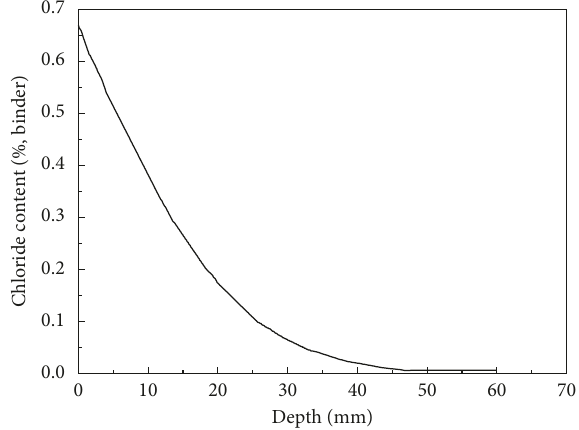
Figure 1: General chloride concentration profiles